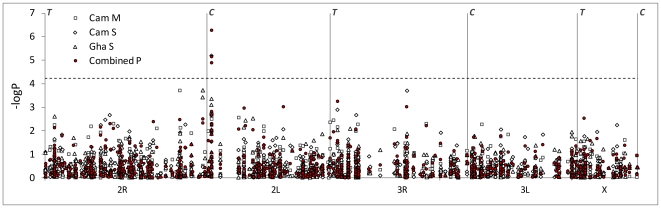
Association test results for each subsample and for P-values combined across populations (Fisher's method).The x-axis is a linear physical scale across each chromosome, with centromeres and telomeres denoted by C and T, respectively. The dashed horizontal line shows the P-value level adjusted for multiple testing by Bonferroni correction of the nominal critical α = 0.05.